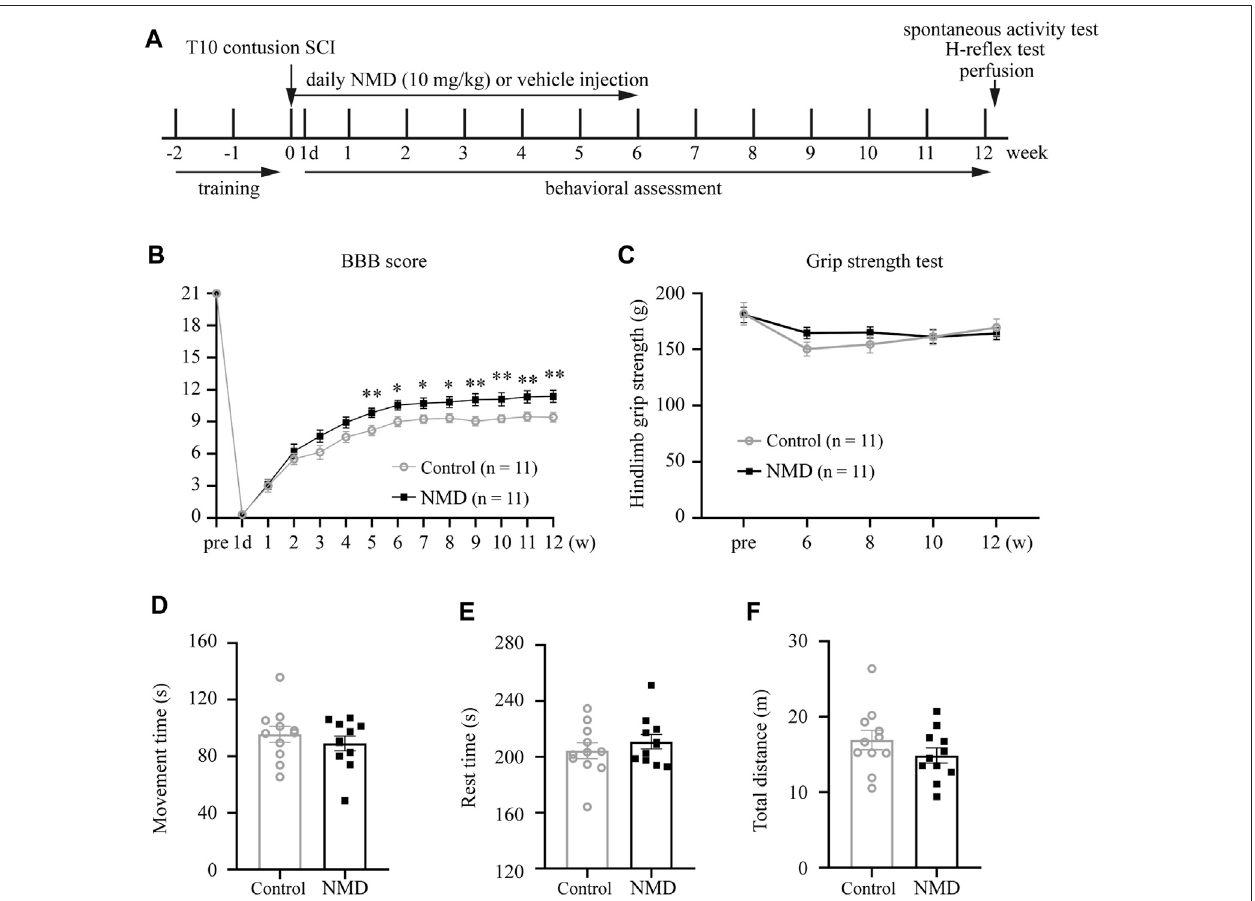
FIGURE 1 | Summary of the experimental design and functional assessments of NMD and control rats following SCI. (A) Schematic illustrating the chronological order of experiments for SCI, drug administration, and functional assessments. (B) Signi fi cant improvements in Basso, Beattie, and Bresnahan (BBB) scores were observed inNMD-treated rats ( n (cid:1) 11in each group). Generalized estimating equation, p (cid:1) 0.008(week 5), 0.013 (week 6), 0.012 (week 7), 0.016 (week 8), 0.004(week 9), 0.008 (week 10), 0.006 (week 11), and 0.005 (week 12). * p < 0.05, ** p < 0.01. (C) Hind limb grip strength test ( n (cid:1) 11 rats in each group). Two-way repeated- measures ANOVA, p > 0.05, F (1, 20) (cid:1) 0.284. (D – F) Open- fi eld spontaneous activity test ( n (cid:1) 11 rats in each group). Unpaired t-test, p >